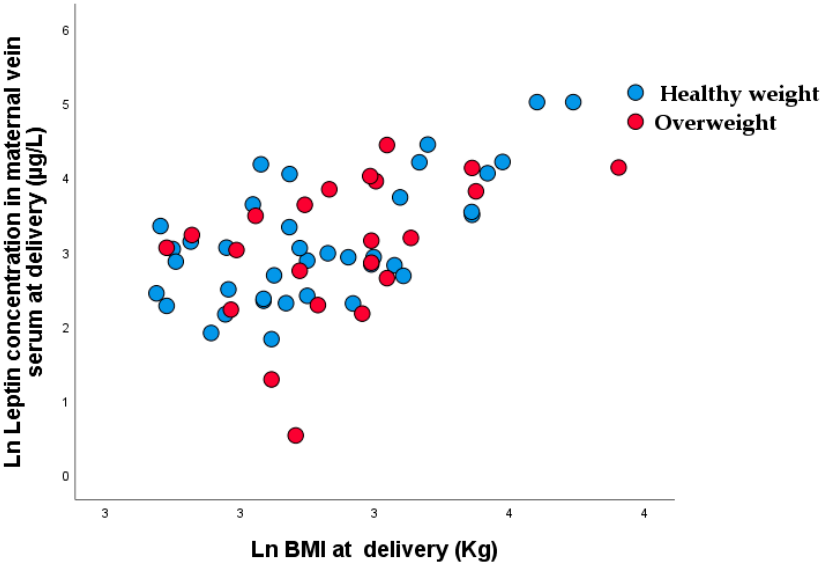
Figure 5. Scatter plot of nonparametric correlations between maternal body mass at the time of delivery and leptin concentrations at the time of delivery (r rho = 0.501, p < 0.001). Significant nonparametric correlations were found between the z-score of neonatal weight and umbilical venous serum leptin concentration (r rho = 0.316, p = 0.014) (Figure 6). Significant nonparametric correlations were found between maternal and umbilical vein venous serum BDNF concentration (r rho = 0.494, p < 0.001) at the time of delivery (Figure